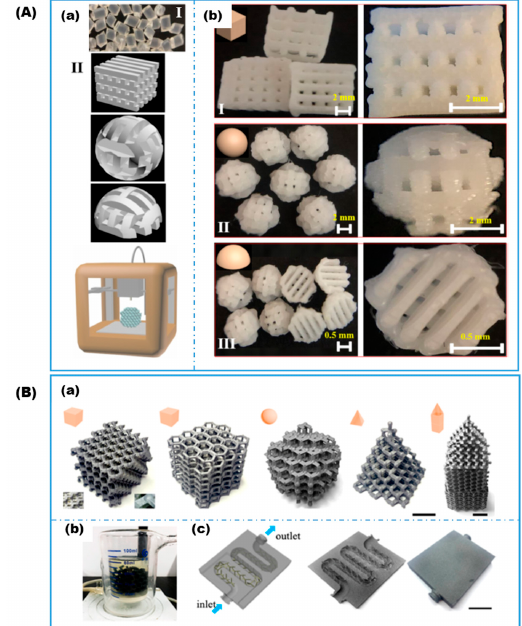
Figure 3. ( A ) The 3D-printed PLA-based macroscaffolds for enzyme immobilization: ( a ) as-received PLA (I) and CAD drawings of the designed scaffolds (II) and ( b ) photos of the 3D-printed scaffolds (reproduced with permission from Ref. [42]). ( B ) The 3D-printed carbon fiber reinforced PLA-based scaffolds for enzyme immobilization: ( a ) CAD images of 3D scaffolds; ( b ) photo of an integrated reactor with immobilized enzymes on 3D-printed scaffold; and, ( c ) 3D models of microfluidic reac- tors with scaffolds in the channel (reproduced with permission from Ref. [56]).